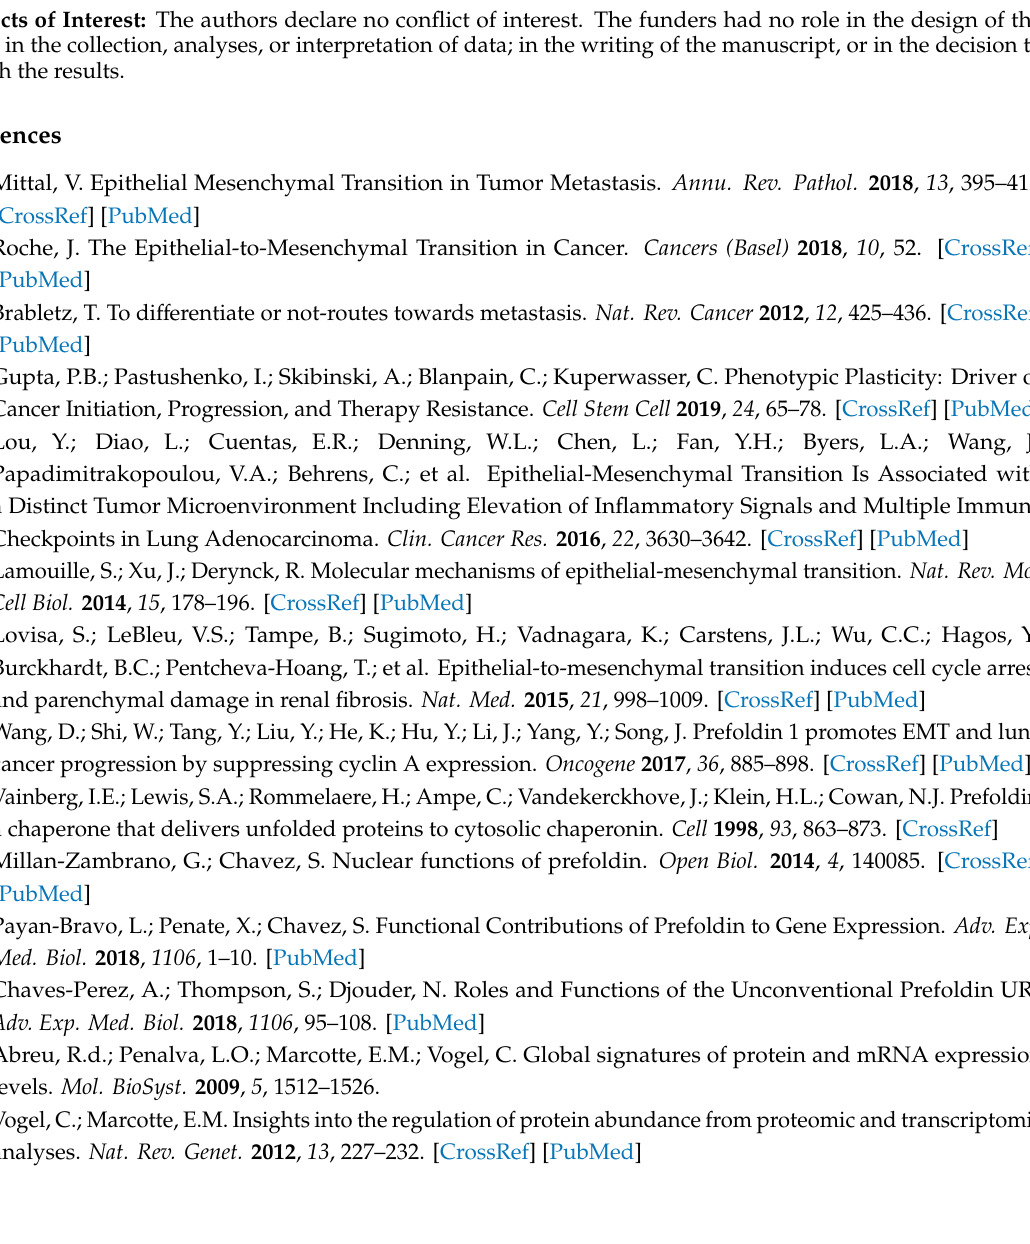
patient characteristics and PFDN expression and